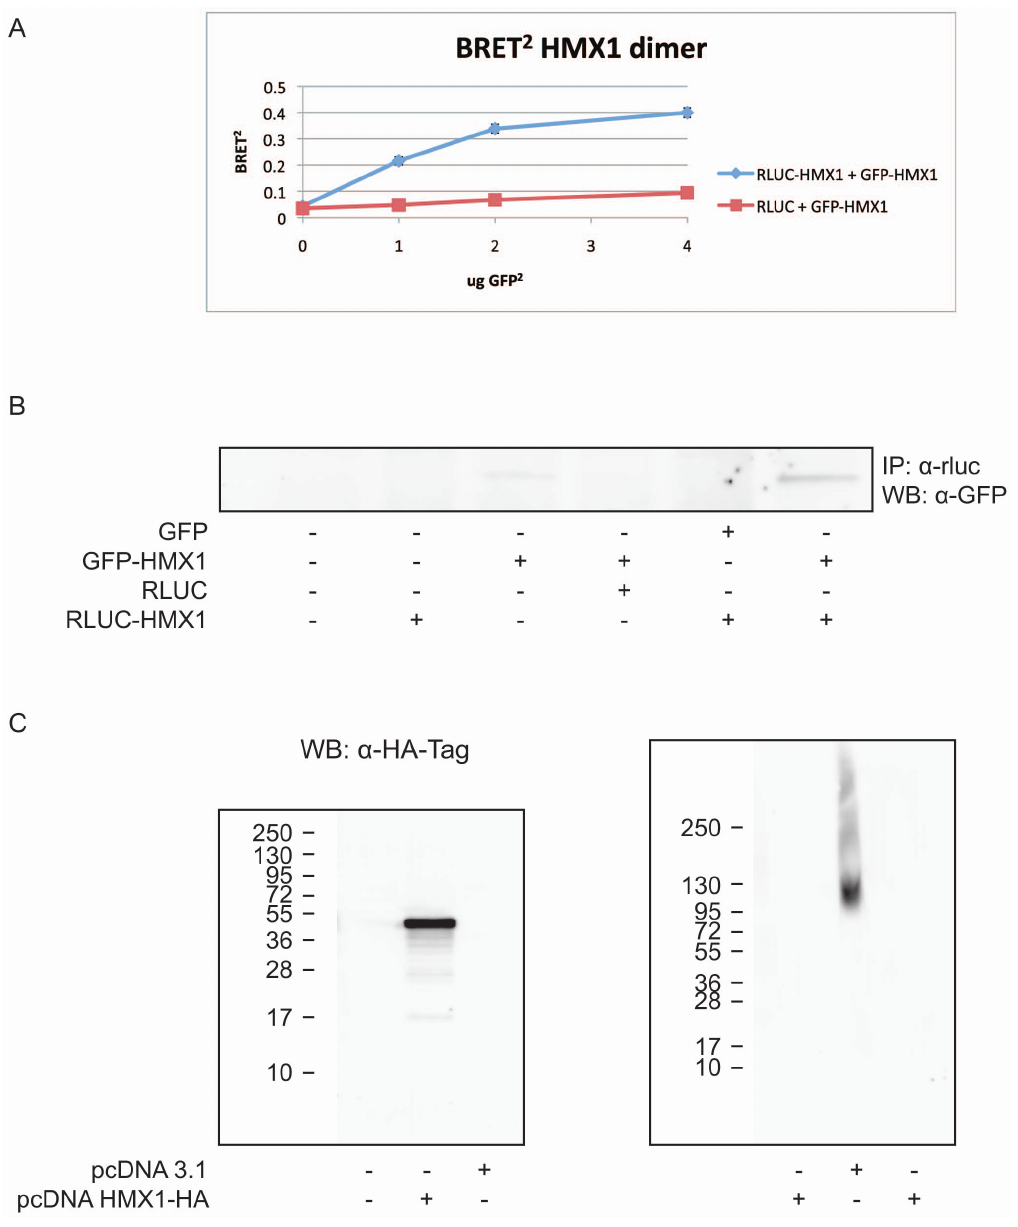
Figure 1. Dimerization of HMX1 in HEK 293T cells. HMX1 is dimerizing as shown by the increasing BRET 2 ratio in presence of the two fusion proteins. Data points represent the mean of two experiments + / 2 SD (A). Co-immunoprecipitation was only observed in presence of the two HMX1 fusion proteins. IP was performed with anti-Renilla Luciferase antibody and WB with anti-GFP antibody (B). The size of the HMX1 band revealed with anti-HA-Tag (6E2) Mouse mAb was twice the size in non-denaturing conditions as in denaturing conditions. As no higher molecular weight bands were observed, it is unlikely that trimers were formed (C).